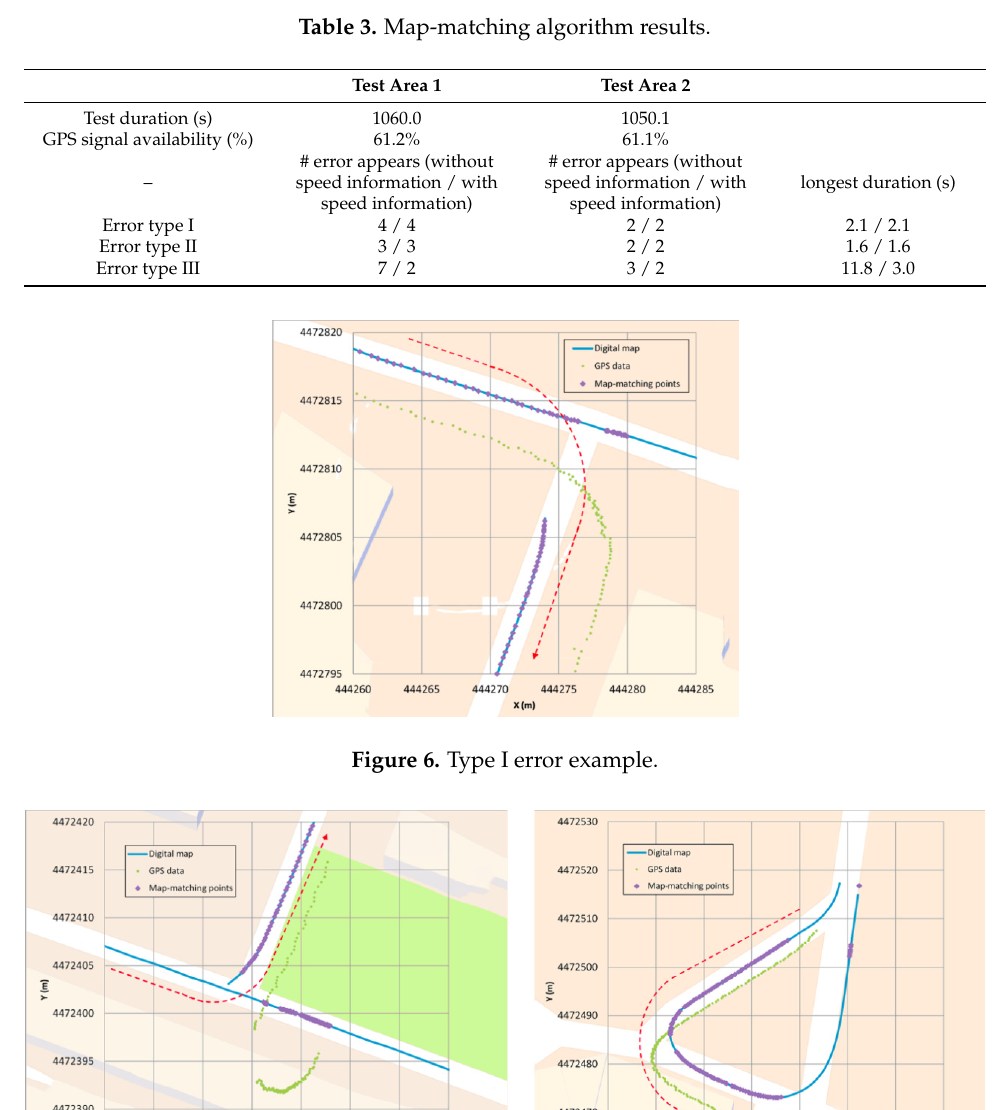
Table 3. Map-matching algorithm results.